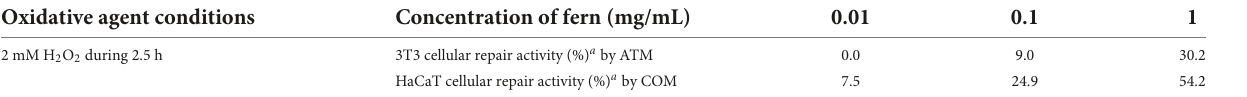
TABLE 3 Cellular repair activity of ATM and COM in 3T3 cell line for 2 mM H 2 O 2 during 2.5 h by MTT assay. Oxidative agent conditions Concentration of fern (mg/mL)